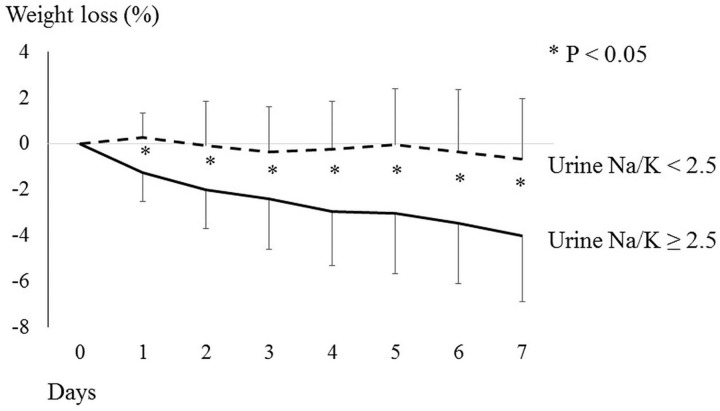
Change in body weight after tolvaptan therapy and baseline spot urine Na/K ratio.The change in mean body weight after tolvaptan therapy is shown over time. The solid line represents patients with baseline spot urine Na/K ≥2.5, and the dotted line represents those with Na/K < 2.5. The error bars indicate standard deviations. Weight loss on day 7 was significantly greater in patients with spot urine Na/K ratios ≥ 2.5 than in those with Na/K < 2.5 (4.0% ± 2.8% vs. −0.7% ± 2.7%, p < 0.05).